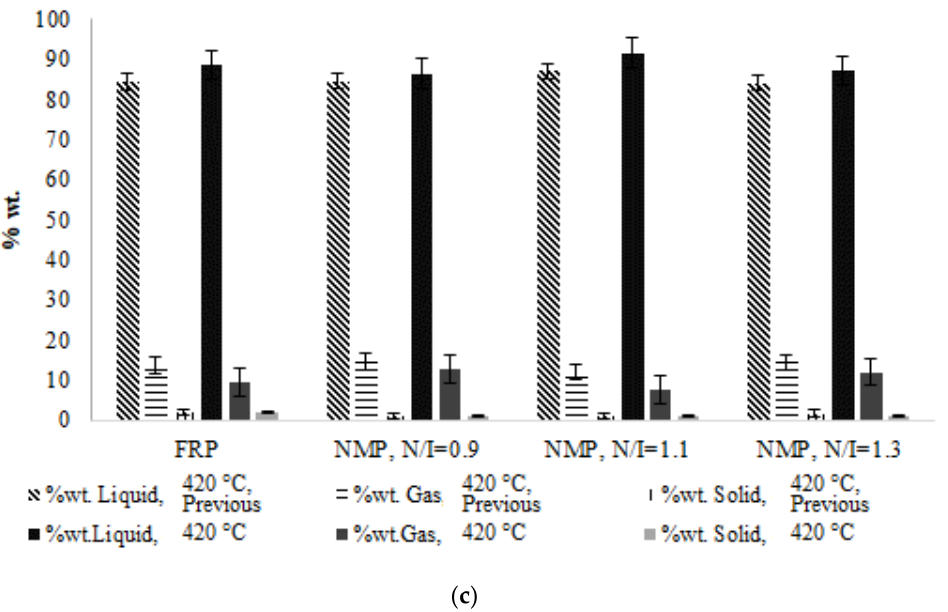
Figure 3. ( a ) Recovered pyrolysis products in the form of liquid, gas, and solids in %wt. relative to the fed sample at 390 °C and 420 °C, ( b ) Recovered pyrolysis products in the form of liquid, gas, and solids in %wt. at 390 °C and their comparison with previous experiments, ( c ) Recovered pyrolysis products in the form of liquid, gas, and solids in %wt. at 420 °C and their comparison with previous experiments. The experimental conditions for all cases are given in Table 2.